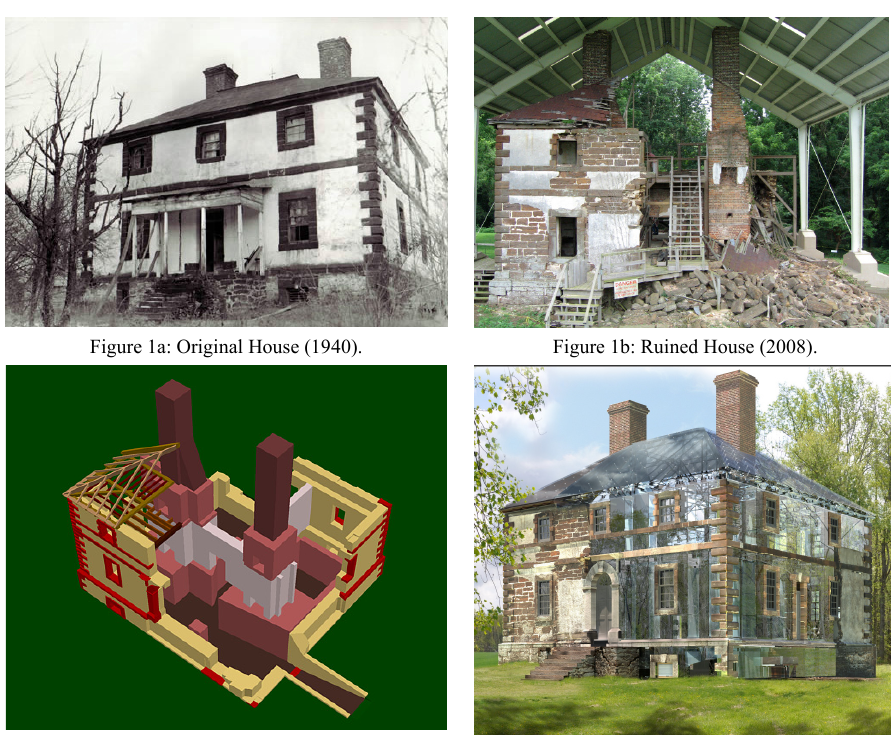
Figure 1c: Geometry Model (DMP). Figure 1d: Graphical Realization (Future